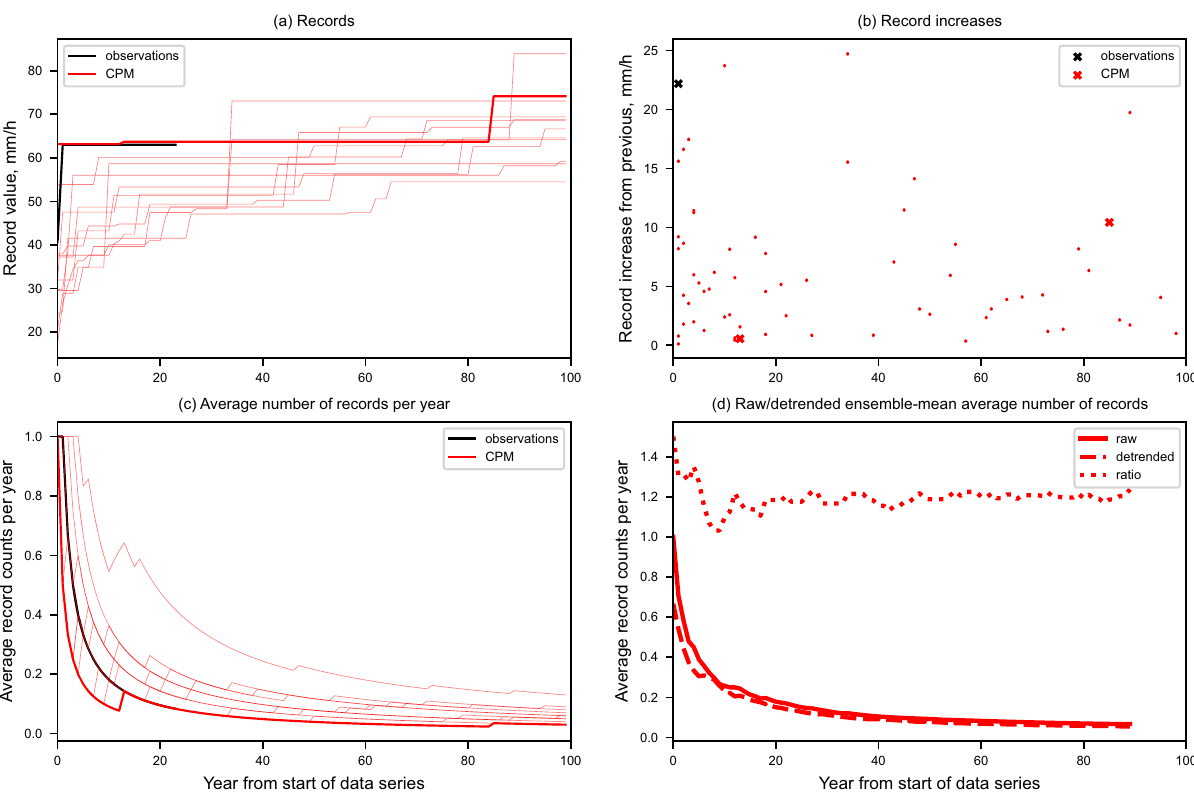
Fig. 8 | Exceedance of UK records in local hourly precipitation. Exceedance of records as a function of year from the start of the dataseries. a Highest value (mm/h) of annual maximum hourly precipitation recorded at any 12km grid-point across the UK since the start of the dataseries, b increase in record from the pre- vious values set, and c average number of records per year from the start of the dataseries.ResultsareshownforCEHGEARobservations(black)for1991 – 2014and